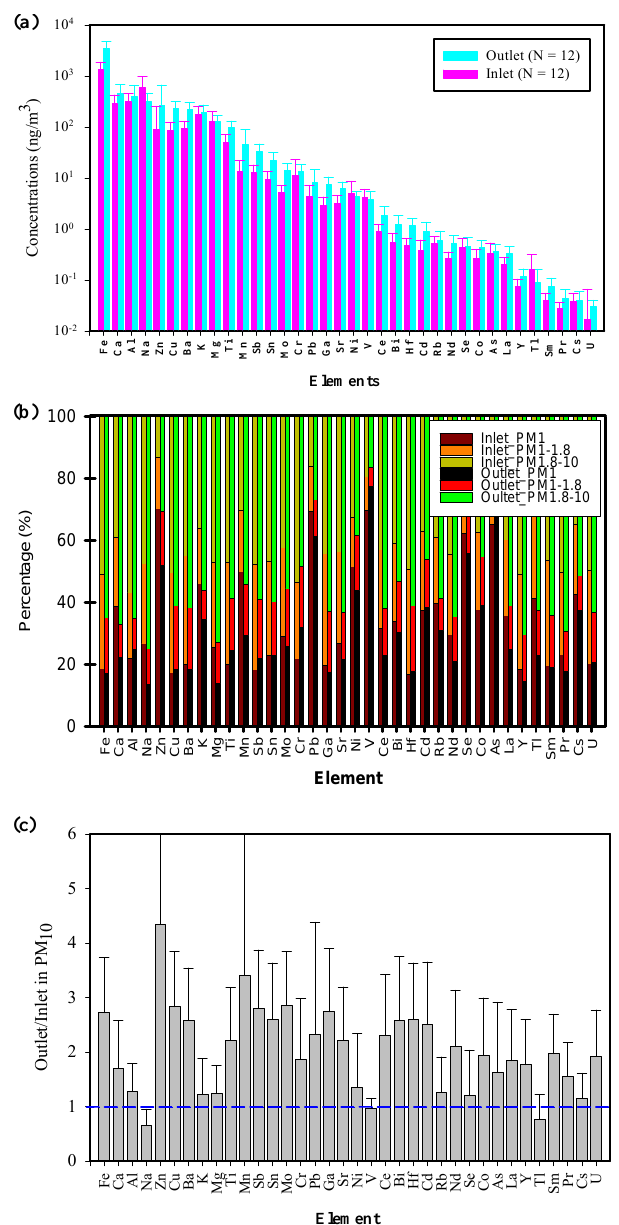
Figure 1. (a) Elemental compositions of PM 10 collected at both the inlet and outlet sites in Hsuehshan Tunnel; (b) partitioning of trace metals within PM of three sizes; (c) outlet-to-inlet ratio for each element in PM 10 . The sequence of metallic species is in order of decreasing concentrations (ngm − 3 ) at the outlet site. N denotes the number of aerosol